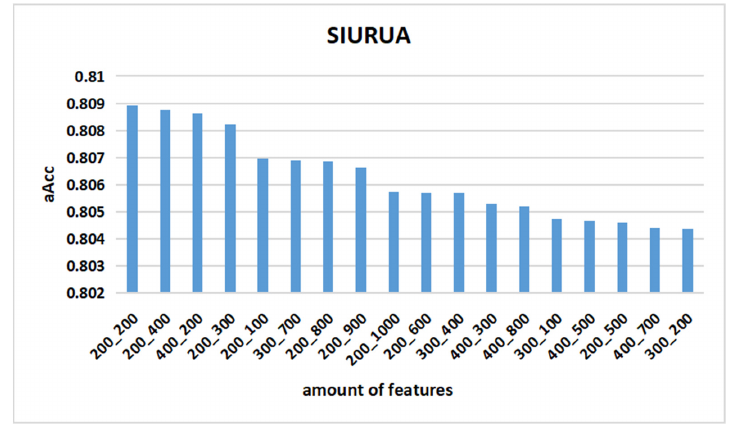
Figure 7. Accuracy of SIURUA in each feature combination.